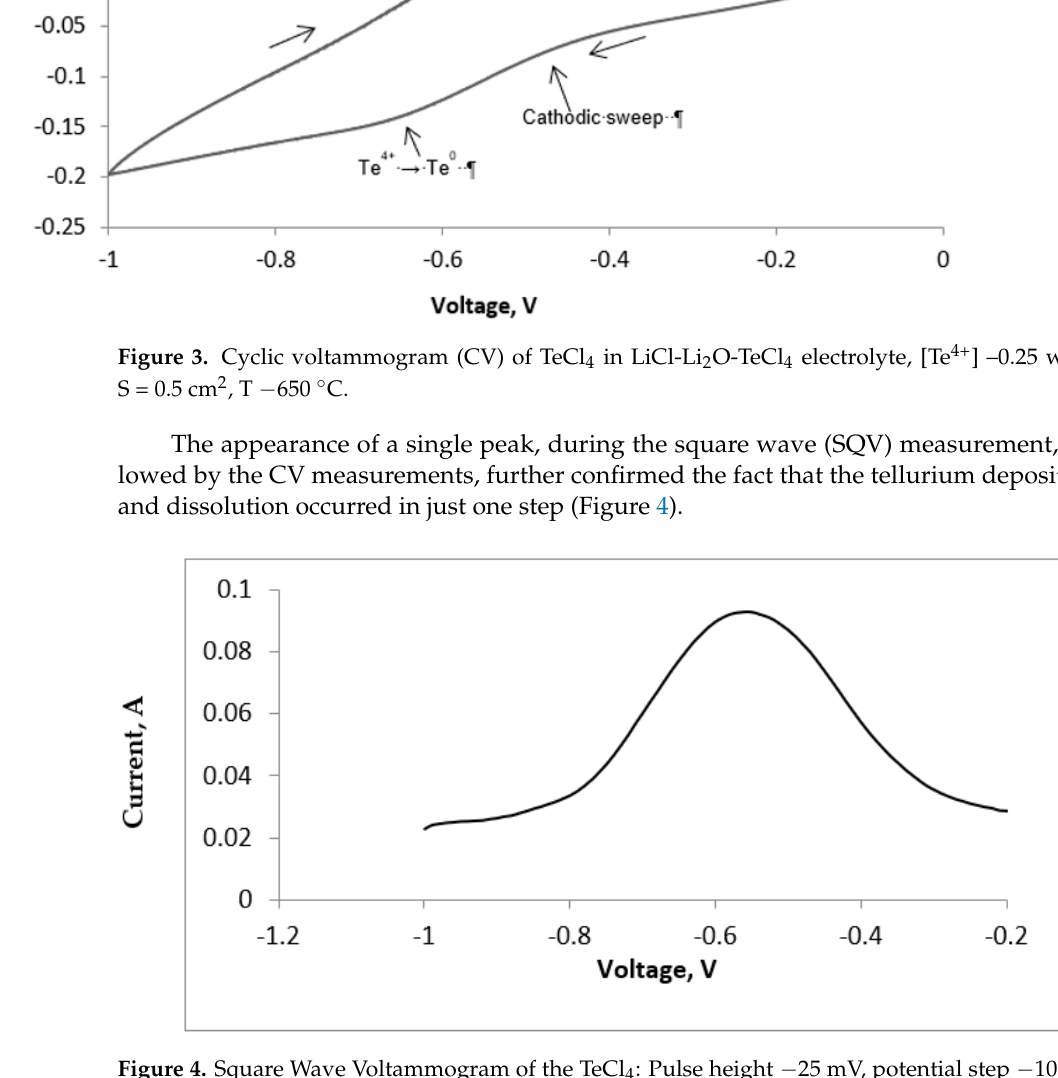
Figure 4. Square Wave Voltammogram of the TeCl 4 : Pulse height − 25 mV, potential step − 10 mV, Frequency − 8 Hz.